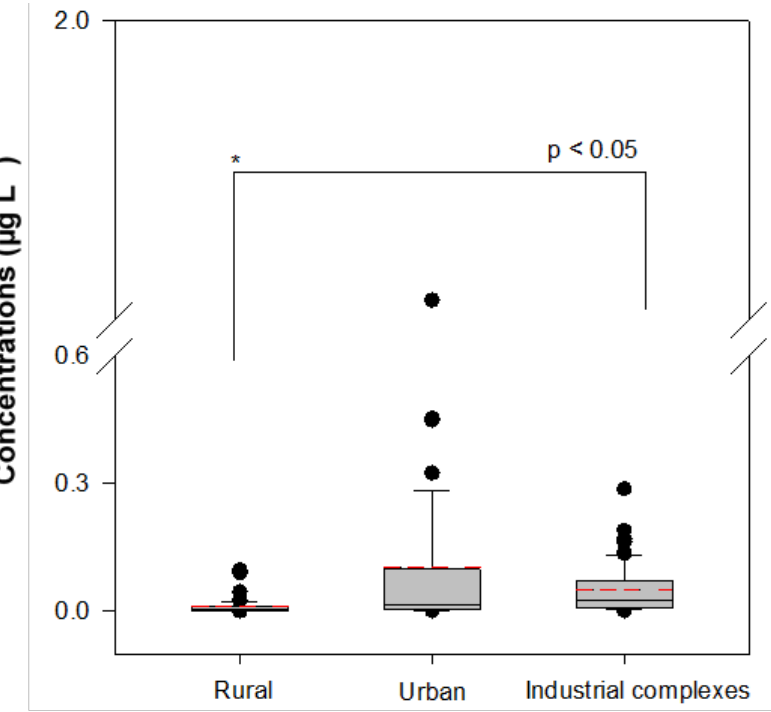
Figure 5. Distributions of VOCs concentrations at potential pollution sources in rural area (sites BR-1 to -5, NR-1 to -7, HIR-1 to -4, and AS-1), urban area (sites HR-1 to -8), industrial complex areas (sites ICS-1 to -11). In the box plot, the boxes indicate 25–75% quartile ranges, central line indicates medians, whiskers indicate data ranges, and red dotted lines indicate average concentrations.